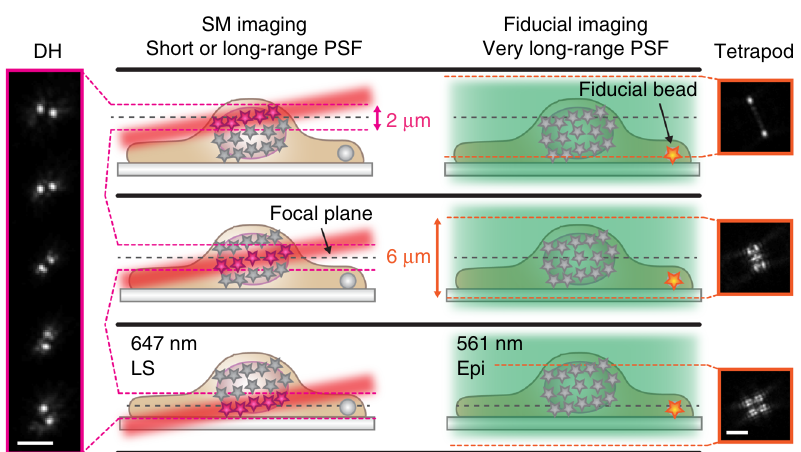
Fig. 2 Schematic of interleaved illumination and detection scheme. Single molecules (SMs) were excited using light sheet (LS) illumination and detected using either a conventional clear aperture point spread function (PSF) or the double-helix (DH) PSF. SM imaging was interleaved with imaging of a fi ducial bead that could be positioned anywhere in the fi eld of view. The fi ducial bead was excited using epi-illumination (Epi) and detected using either the DH-PSF or a very long axial range tetrapod PSF to allow illumination and detection independent of the axial position of the bead. The fi ducial bead was localized in real time and the sample drift was corrected in the axial direction. The illumination was also interleaved with SM reactivation using a 405 nm laser when needed. In the example shown here, SMs over 2- μ m axially were detected with the DH-PSF and fi ducial beads imaged with a 6- µ m axial range tetrapod PSF. The schematic is not to scale. Scale bars are 3 µ m